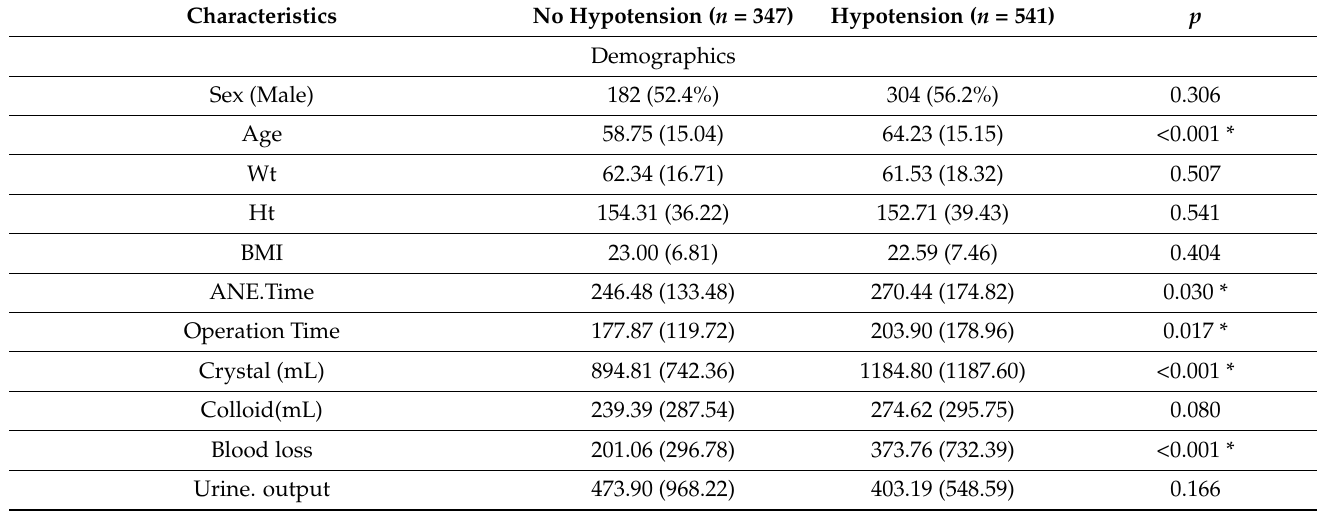
Table A1. Clinical patient characteristics in terms of demographics, operation records, preoperative test results, and past disease history (% for discrete variable or standard deviation for continuous